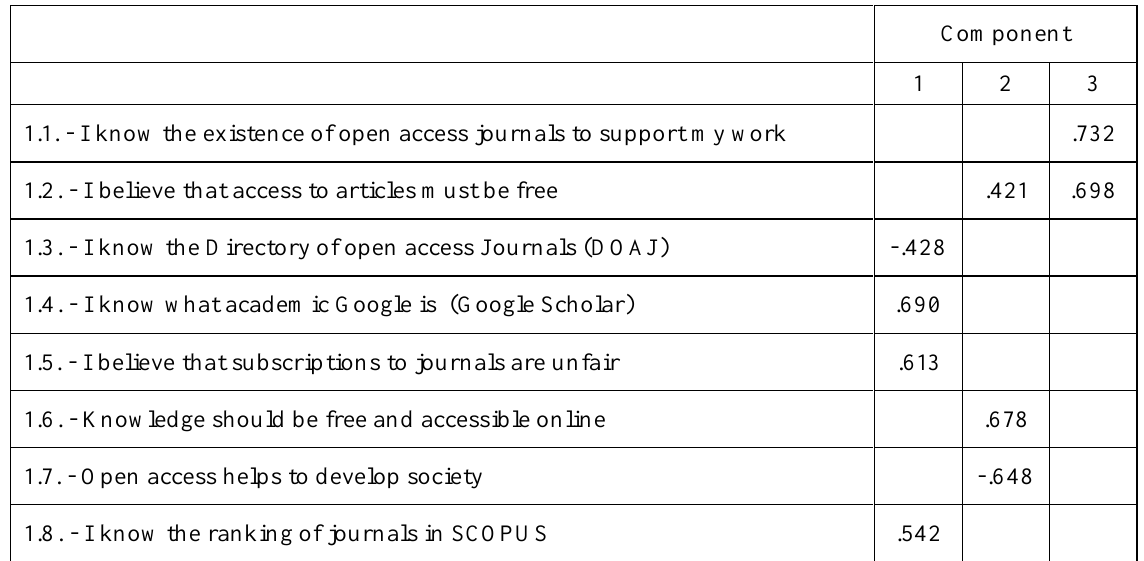
Dimension 1. Rotated Component Matrix. Extraction Method: Principal Components Analysis. Rotation Method: Varimax with